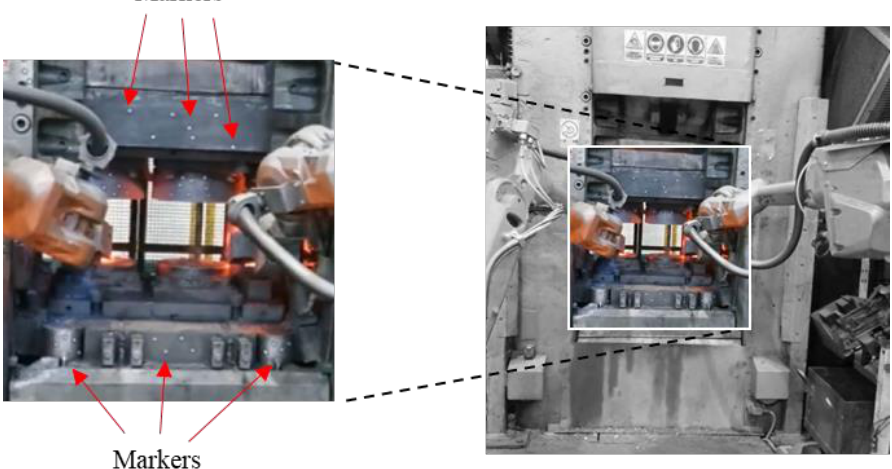
Figure 6. View of the press frame with visible markers.